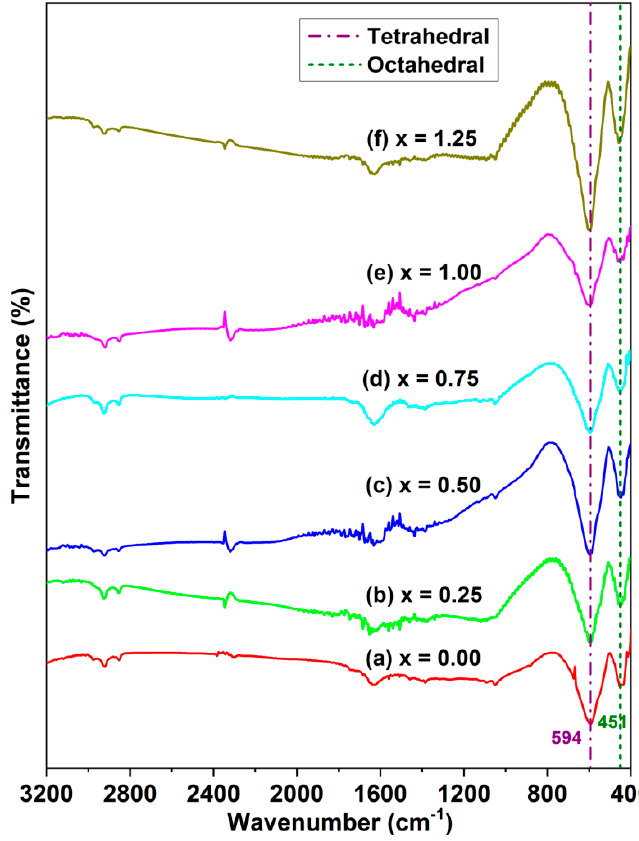
Figure 3. FT-IR spectra for the W-type SrYb hexaferrite Sr 0.85 Yb 0.15 Zn 1.5 Co 0.5 Al x Fe 16 − x O 27 (0.00 ≤ x ≤ 1.25).